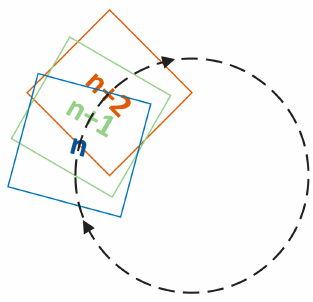
Figure 9. Scanning path and number rules during scanning and data